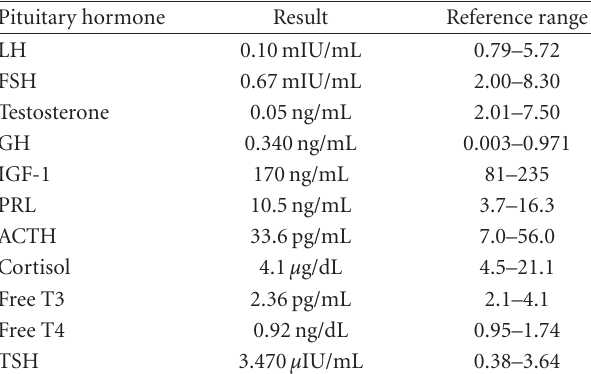
Table 1: The patient’s pituitary hormones at